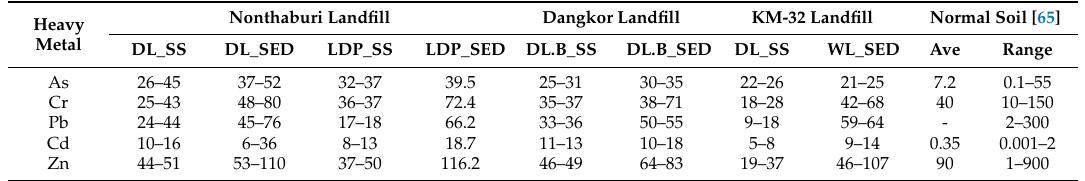
Table 4. The HM contents of this study and that commonly found in normal soils (mg/kg).